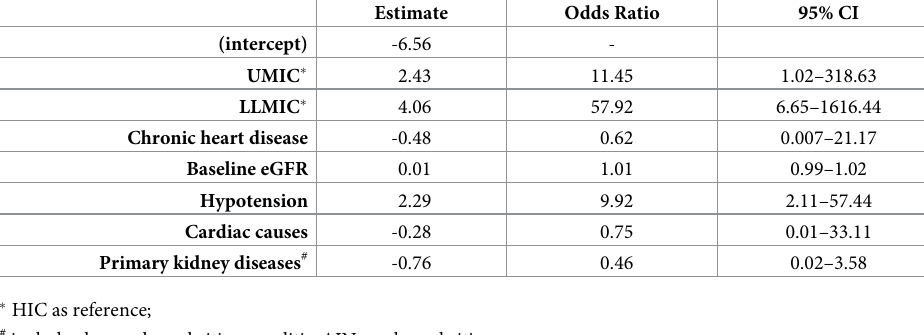
Table 5. Multivariable logistic regression for mortality in patients with